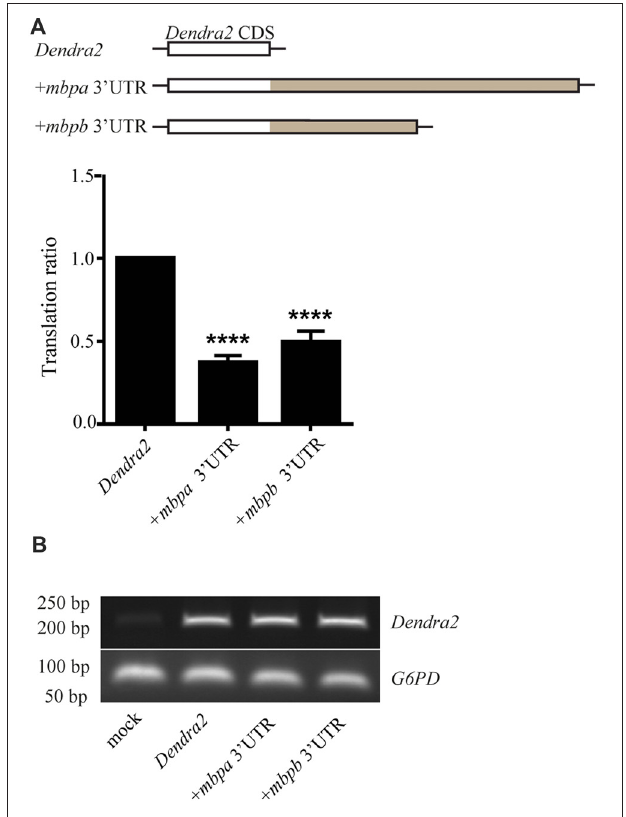
FIGURE 4 | The 3’UTRs from mbpa and mbpb inhibit mRNA translation in cultured cells. (A) The 3’UTR from either mbpa or mbpb was inserted into a reporter construct containing the coding region of Dendra2 . The constructs were co-transfected with a DsRed-expressing vector into Oli-Neu cells and protein expression measured by flow cytometry. The relative Dendra2 expression, displayed as the translation ratio, was calculated as described in the “Materials and Methods” section. The results represent the means from three independent experiments ± SD. For each experiment, at least 25 × 10 3 cells were analyzed. ∗∗∗∗ p < 0.0001. (B) Total mRNA was purified from a fixed number of transfected cells and used as template for RT-PCR with primers recognizing Dendra2 or the house-keeping gene G6PD